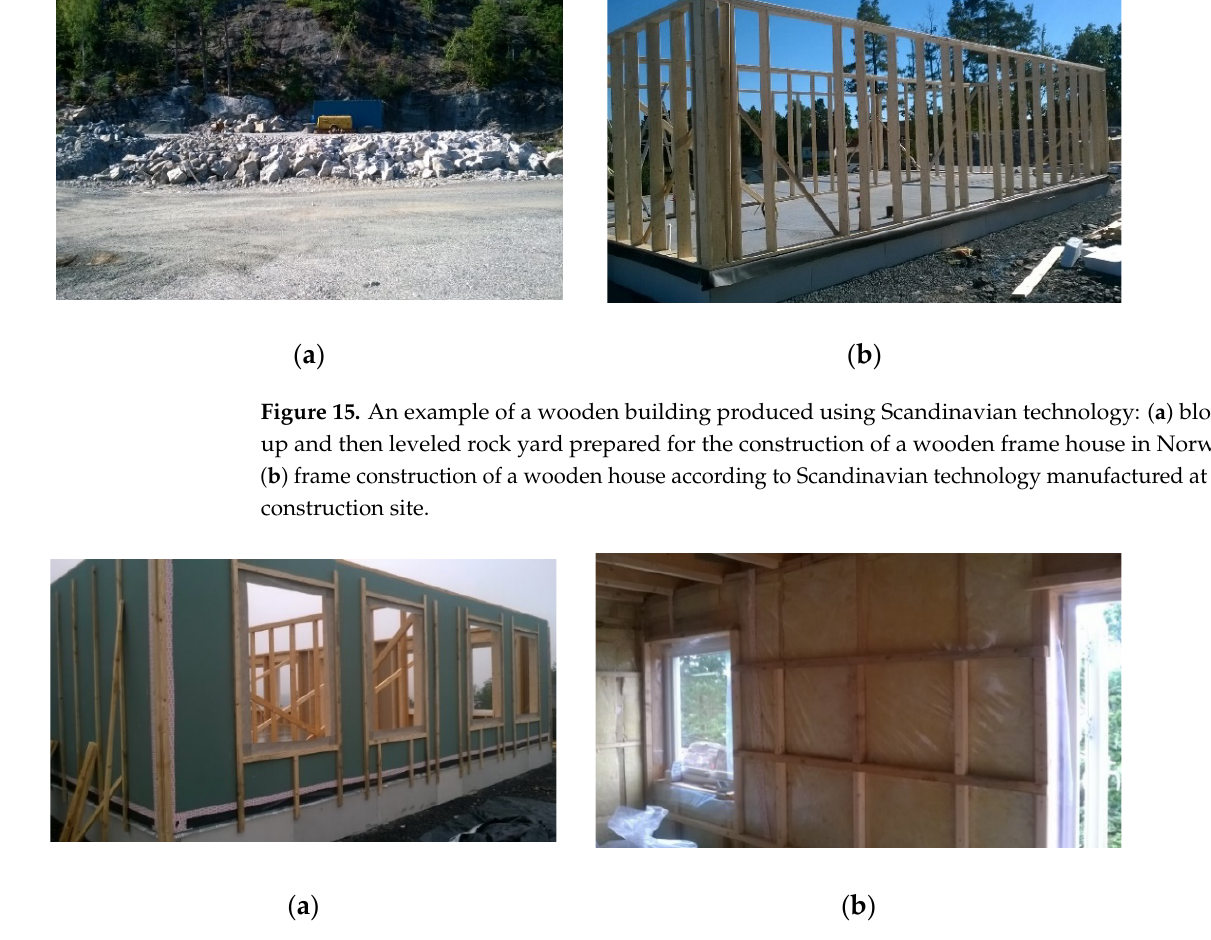
Figure 16. An example of a wooden building produced using Scandinavian technology: ( a ) frame construction of Scandinavian house; ( b ) construction of a wooden frame house with vapor barrier and thermal insulation.